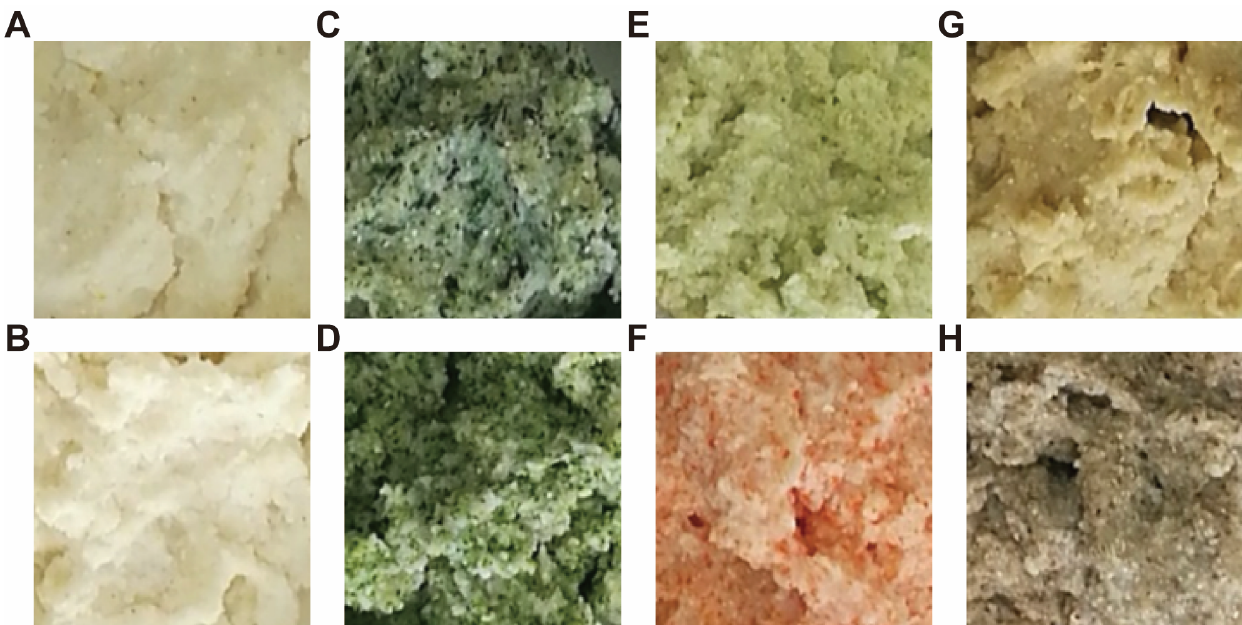
Figure 3. Images of differently fortified ugali . Images were taken right before different ugali presented to the accessors and in a close view that the color and granules could be clearly observed. ( A , B ) are the plain ugali with no vegetable addition.